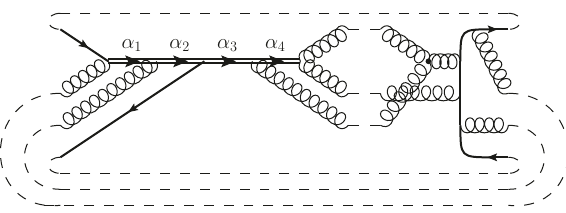
Figure 2 . Example of a scalar product between a basis vector and a color structure, the dashed lines indicate how the external color indices should be